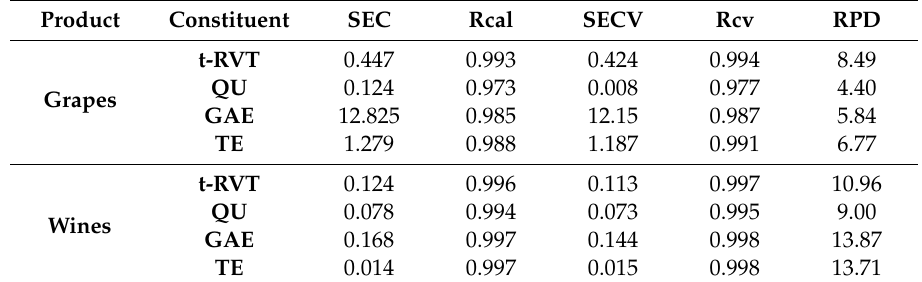
Table 3. Statistical data of the calibration equations for NIR spectroscopy determination of antioxidant constituents and antioxidant activities in red wine grapes and